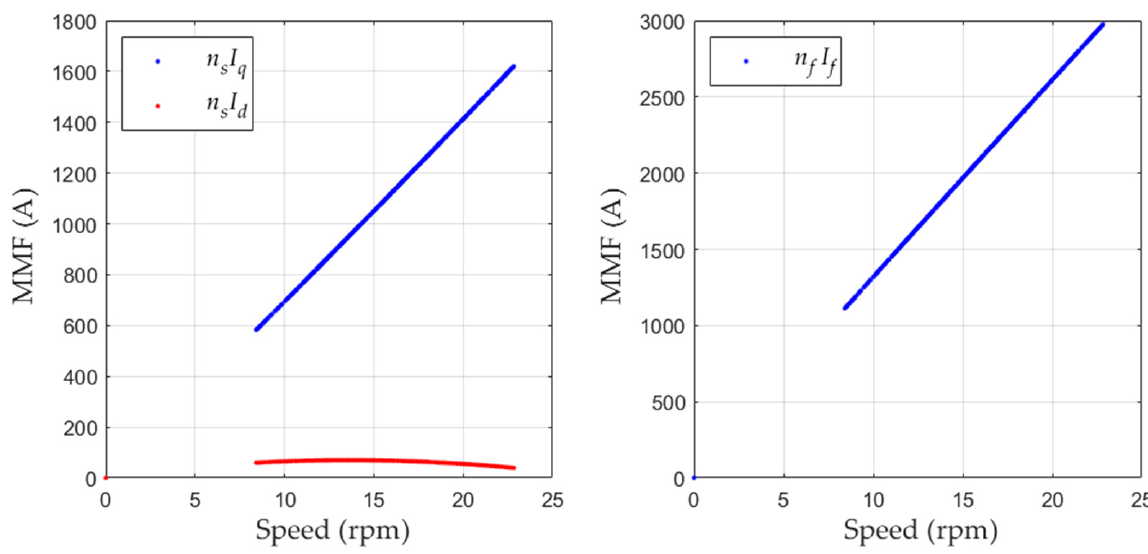
Figure 10. Optimal control strategy with the speed of the optimal generator.